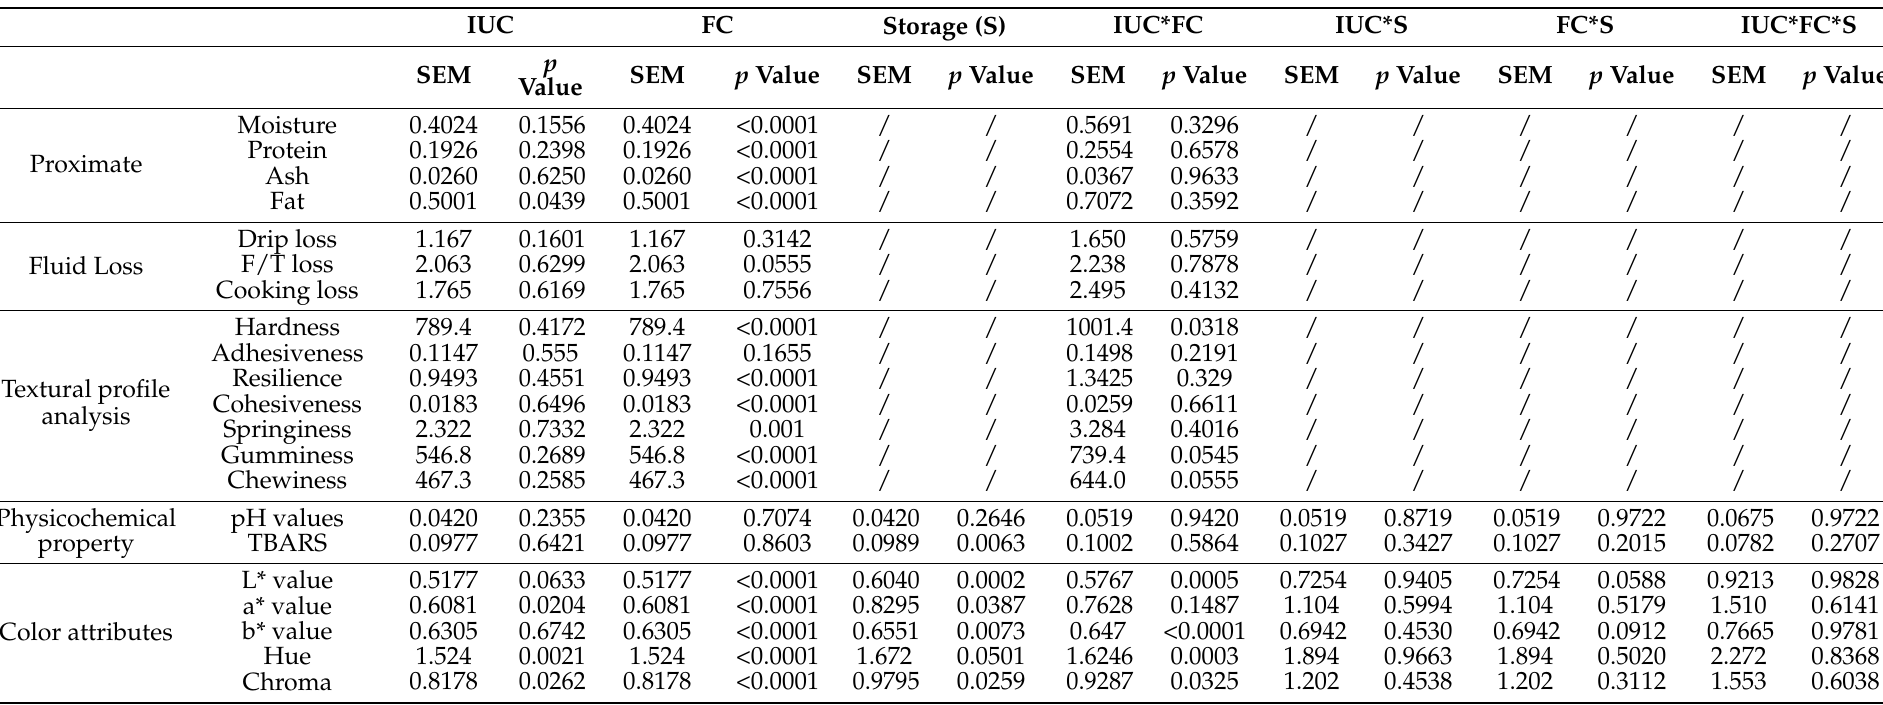
Table 1. Main and interactive effects of gestational condition, fat content, and storage period on quality attributes of pork